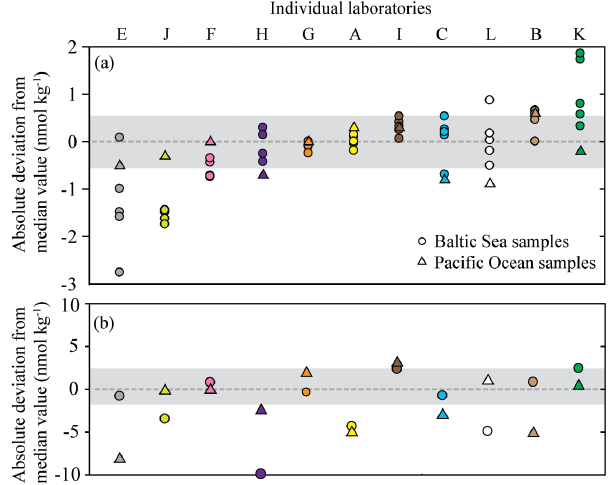
Figure 5. Deviation from the median value (reported in absolute units) for nitrous oxide datasets. The batches of samples include BAL1, 2, 3, 6, and 7 (a) and PAC2 and BAL5 (b) . The Baltic Sea samples are represented by circles and the Pacific Ocean samples are represented by triangles. The shaded area indicates a deviation ≤ 5% from the median value based on a water-column concen- tration of 11 and 42nmolkg − 1 for (a) and (b) , respectively. The color scheme for each laboratory dataset is identical to that used in Fig. 4 and the letters allocated to each dataset are to facilitate cross- referencing in the text. Note the y axis for (a) and (b) are plotted on a different scale.